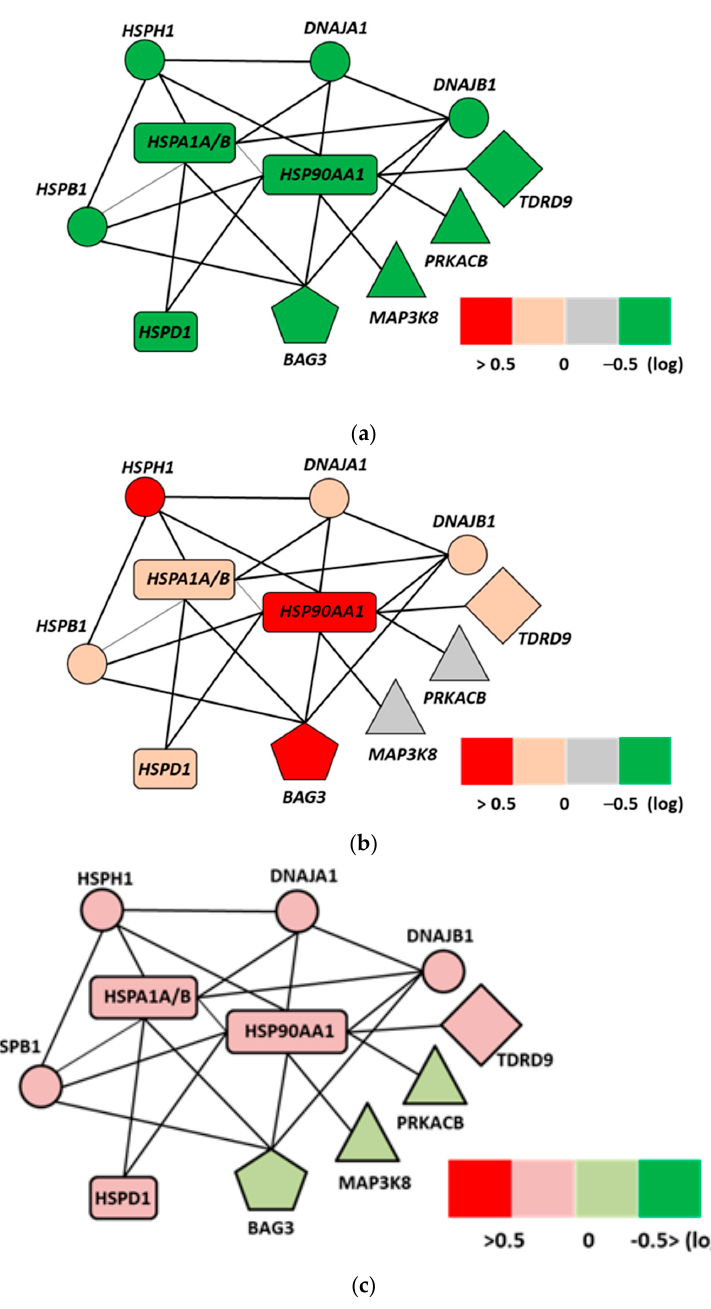
Figure 4. Ingenuity analysis of the network of HSP-related interactions at a genetic level [105]: ( a ) control samples ( 38 ℃ ), ( b ) wHT-treated samples ( 42 ℃ ), ( c ) mEHT ( 42 ℃ ). Important differences between wHT and mEHT treatments at the same temperature: the less intensive tumor-protective HSP functions in the mEHT sample; the pro-tumor BAG3 remains nonregulated in the mEHT sample.